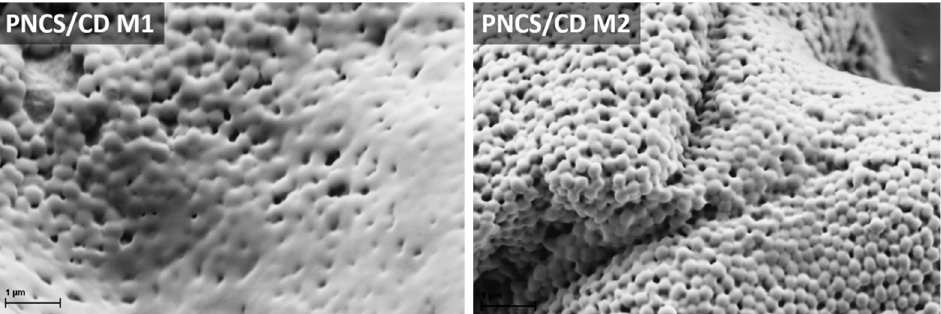
Figure 2. Scanning electron microscope images of the studied PNCS/CD hydrogels.